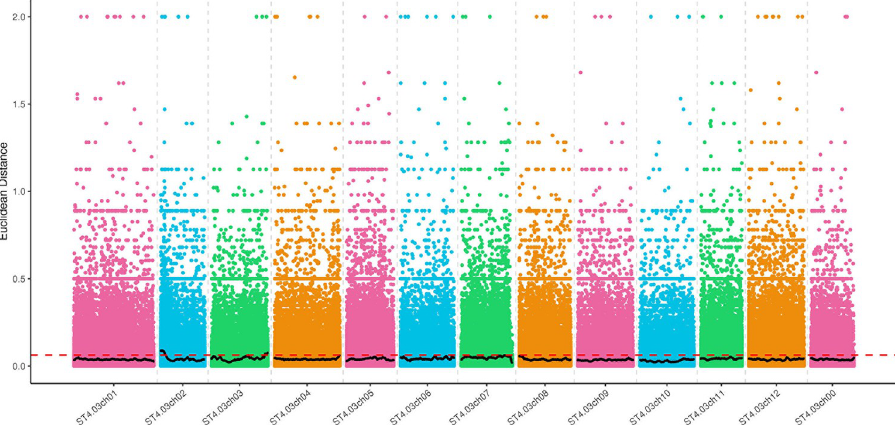
Fig 2. Distribution of ED correlation values on chromosomes. The abscisic coordinate is the potato chromosome abbreviation, the colored point represents the ED value of each SNP site, the black line represents the fitted ED value, and the red dotted line represents the significance correlation threshold. The higher the ED value, the better the correlation effect.